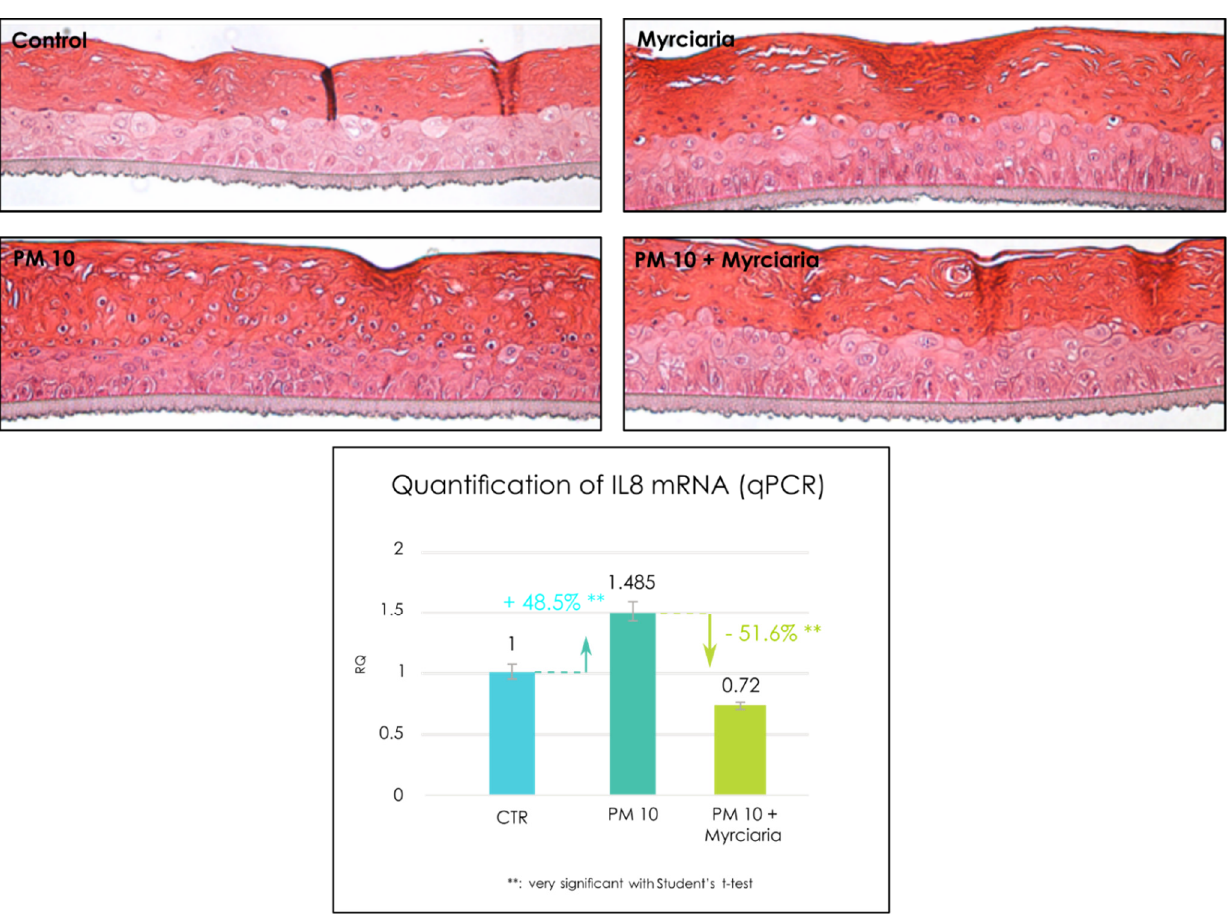
Figure 3. Effect of Myrciaria Dubia fruit extract on inflammation induced by pollutant (PM10) on RHPE. Histological observation was performed on RHPE after hematoxylin/eosin staining. RHPE were pretreated with Myrciaria Dubia fruit extract once a day for 2 days from Day 10. PM10 (particulate matter < 10 µm) were applied at day 12 for 24 h. Staining was performed on RHPE at day 14.